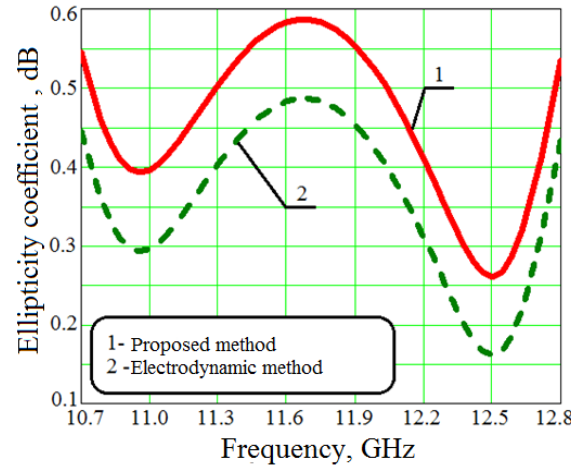
FIGURE 6. Dependences of LVSW on frequency for a waveguide polarizer